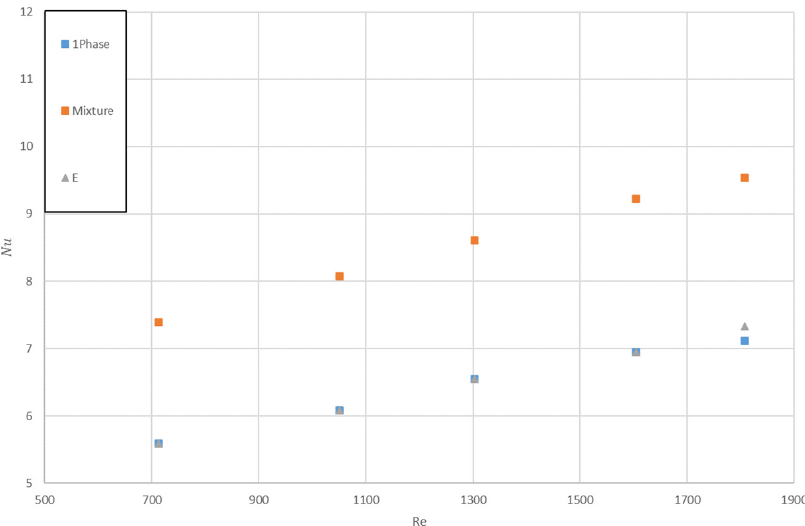
Figure 2. Nu ‐ Re relationship for water–Al 2 O 3 (1%) nanofluid and x/D = 63—data source